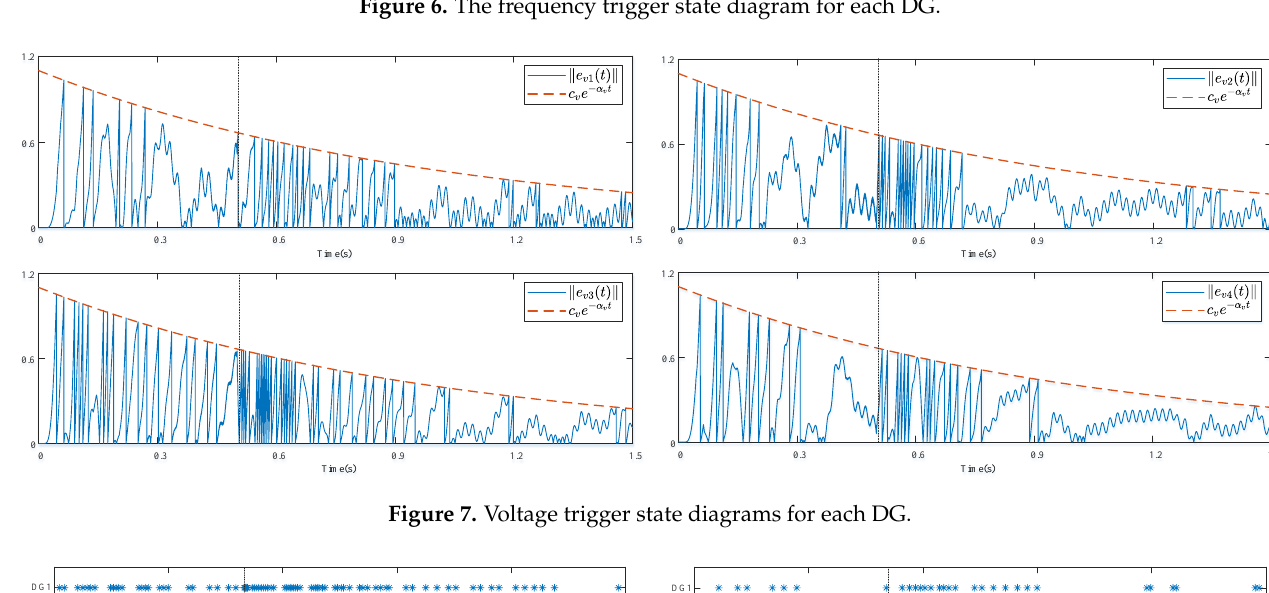
Figure 6. The frequency trigger state diagram for each DG.